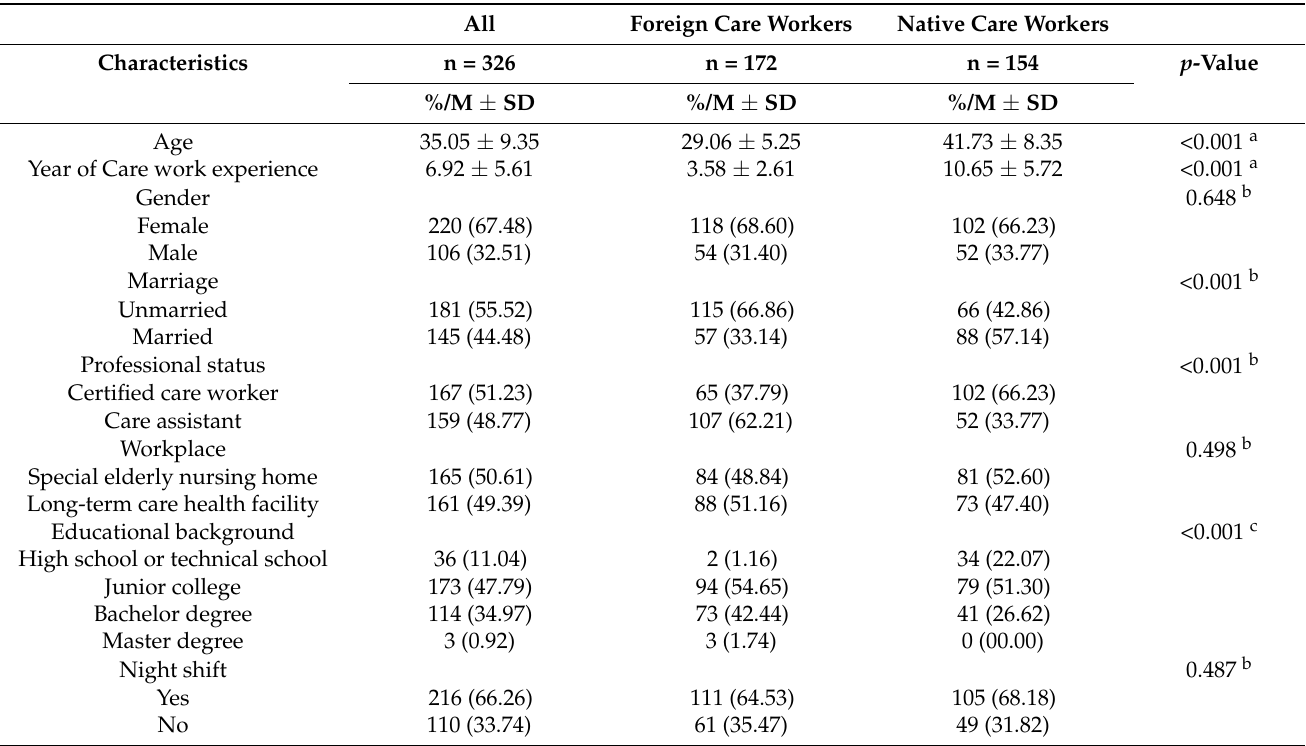
Table 1. Demographic characteristics of care workers (n = 326). All